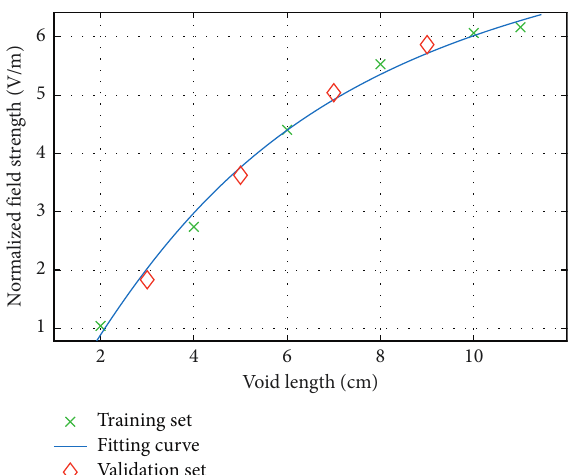
Figure 13: Void size-echo amplitude regression curve of RC structure.